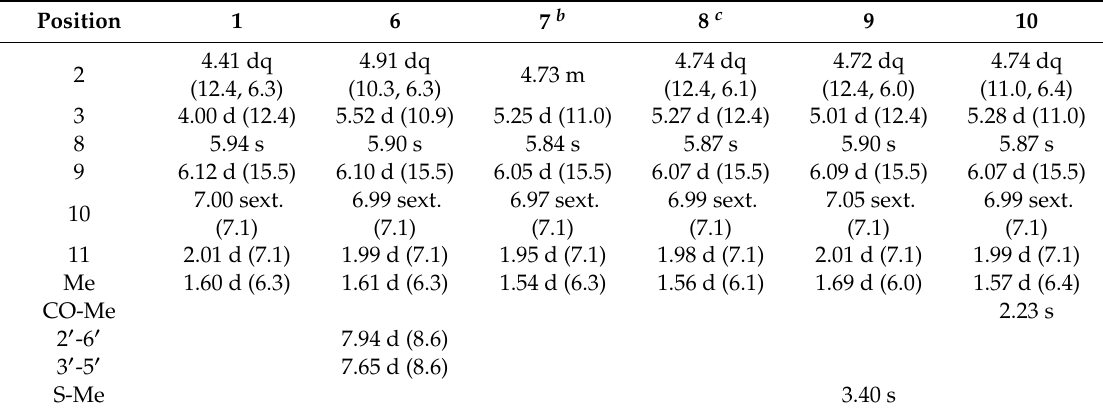
Table 1. 1 H-NMR data of radicinin ( 1 ) and some of its derivatives ( 6 – 10 ) a .